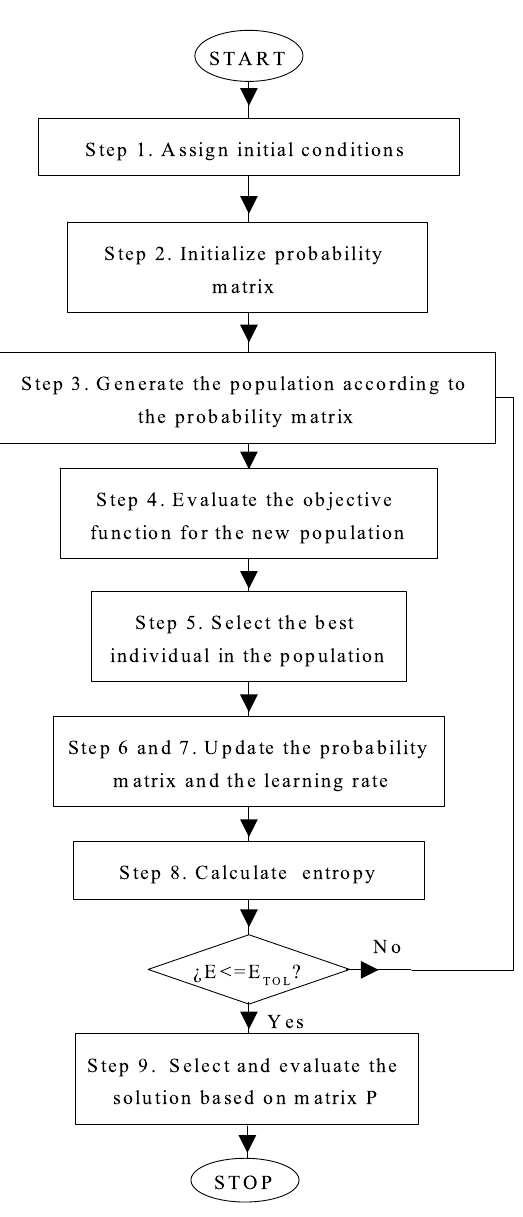
Figure 3. Flowchart of the Population-Based Incremental Learning (PBIL)